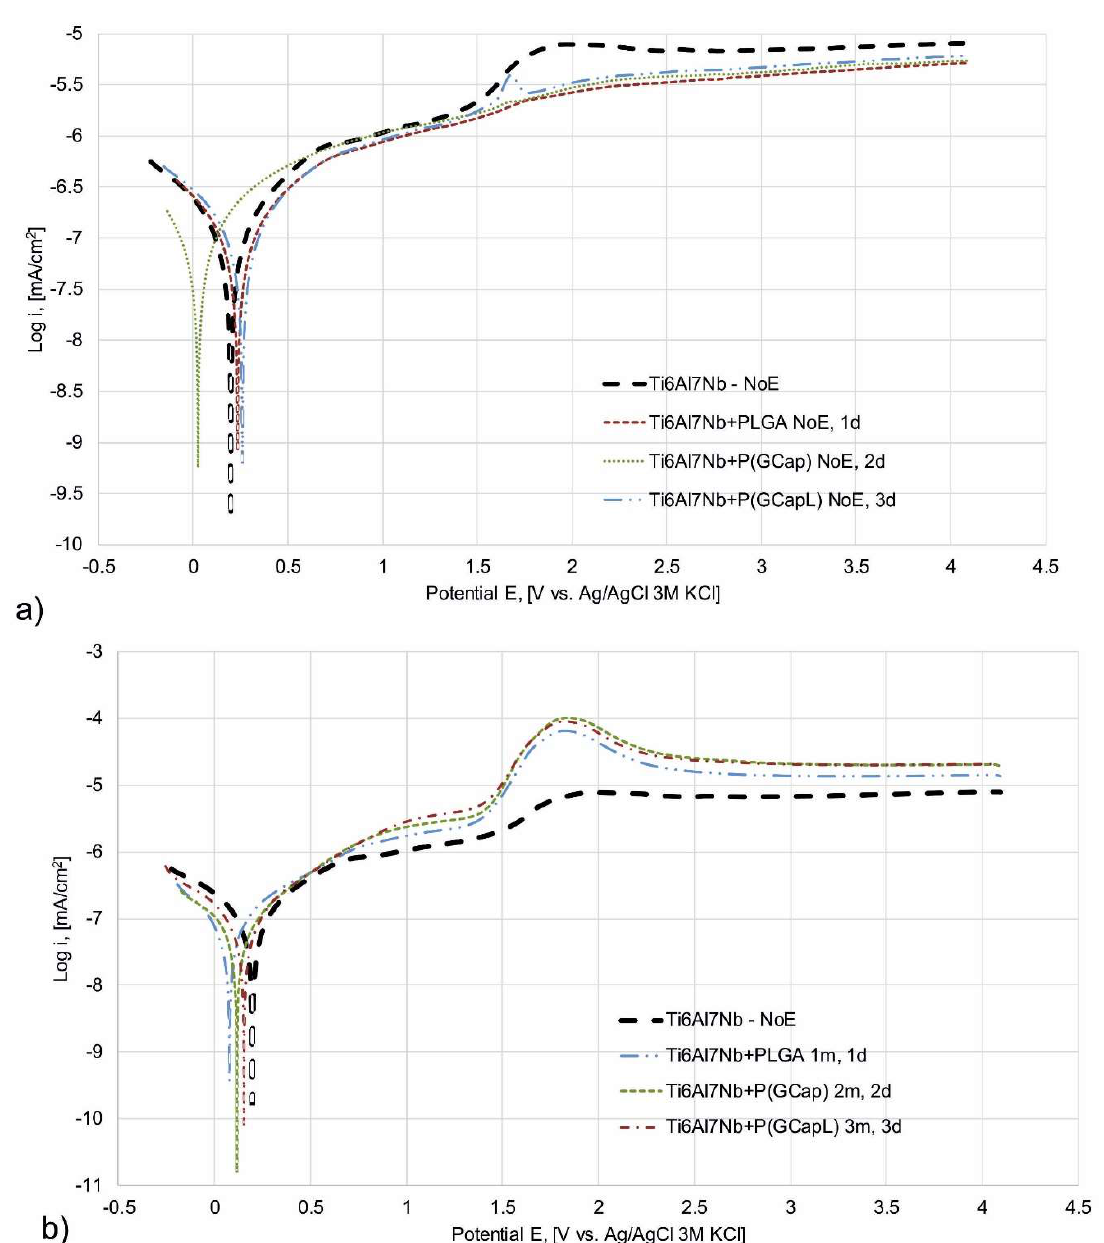
Figure 3. Sample polarization curves of Ti6Al7Nb in the initial state and the alloy with: ( a ) PLGA, P(GCap), and P(GCapL) coatings obtained as a result of different number of dips—1, 2, and 3, respectively (no exposition to Ringer’s solution—NoE); ( b ) Ti6Al7Nb—NoE, PLGA (1 dip; 1 m); P(GCap) (2 dips; 2 m) and P(GCapL) (3 dips; 3 m) polymer coatings.